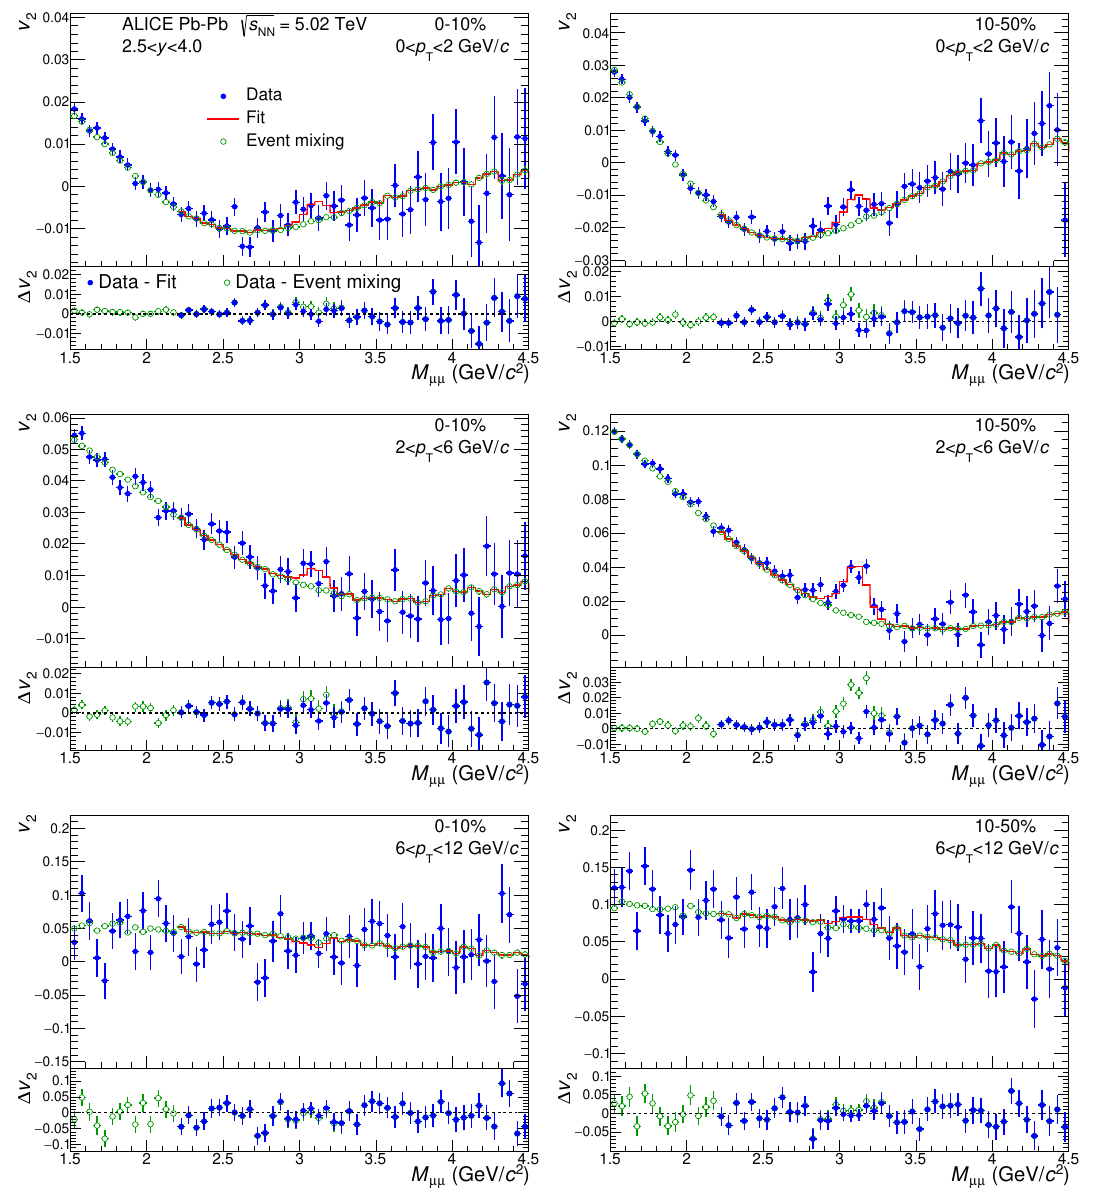
Figure 2 . (Color online) The v 2 ( M (cid:22)(cid:22) ) distribution in low (top panels), intermediate (middle panels) and high (bottom panels) p T intervals for central (left panels) and semi-central (right panels) collisions. The data are (cid:12)tted with the function from eq. 3.2, where the background coe(cid:14)cient v B ( M (cid:22)(cid:22) ) is (cid:12)xed using the event-mixing procedure. The background coe(cid:14)cient v B 2 down to 1.5 GeV/ c 2 is also presented. Only statistical uncertainties are shown.